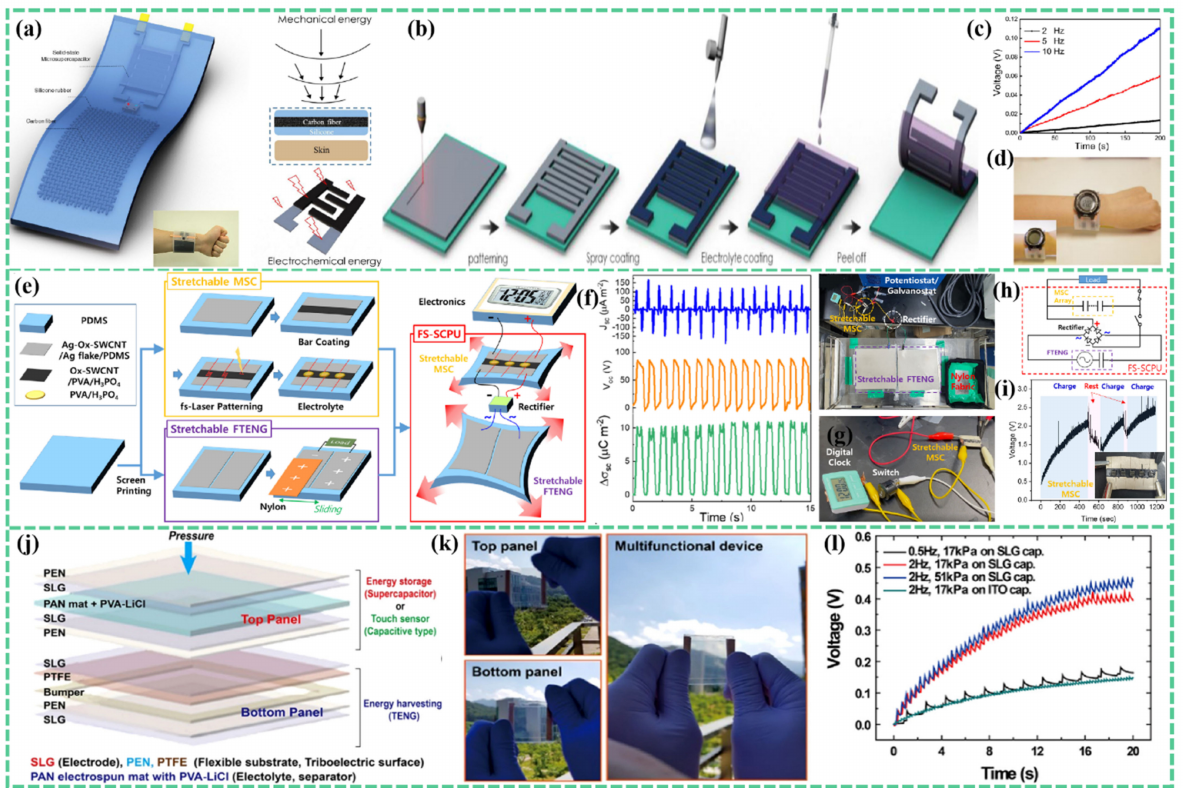
Figure 8. ( a – d ) An electrochemical MSC based on Mxene is integrated with a TENG as a wearable TENG-UPS. ( a ) Schematic diagram of the whole device. ( b ) Schematic illustrating fabrication protocols of Ti 3 C 2 T x MSC. ( c ) Charging curve of the MSC charged by TENGs at various frequencies. ( d ) Digital photos showing MSC to drive a digital watch. Reproduced with permission [92]. Copyright 2018,